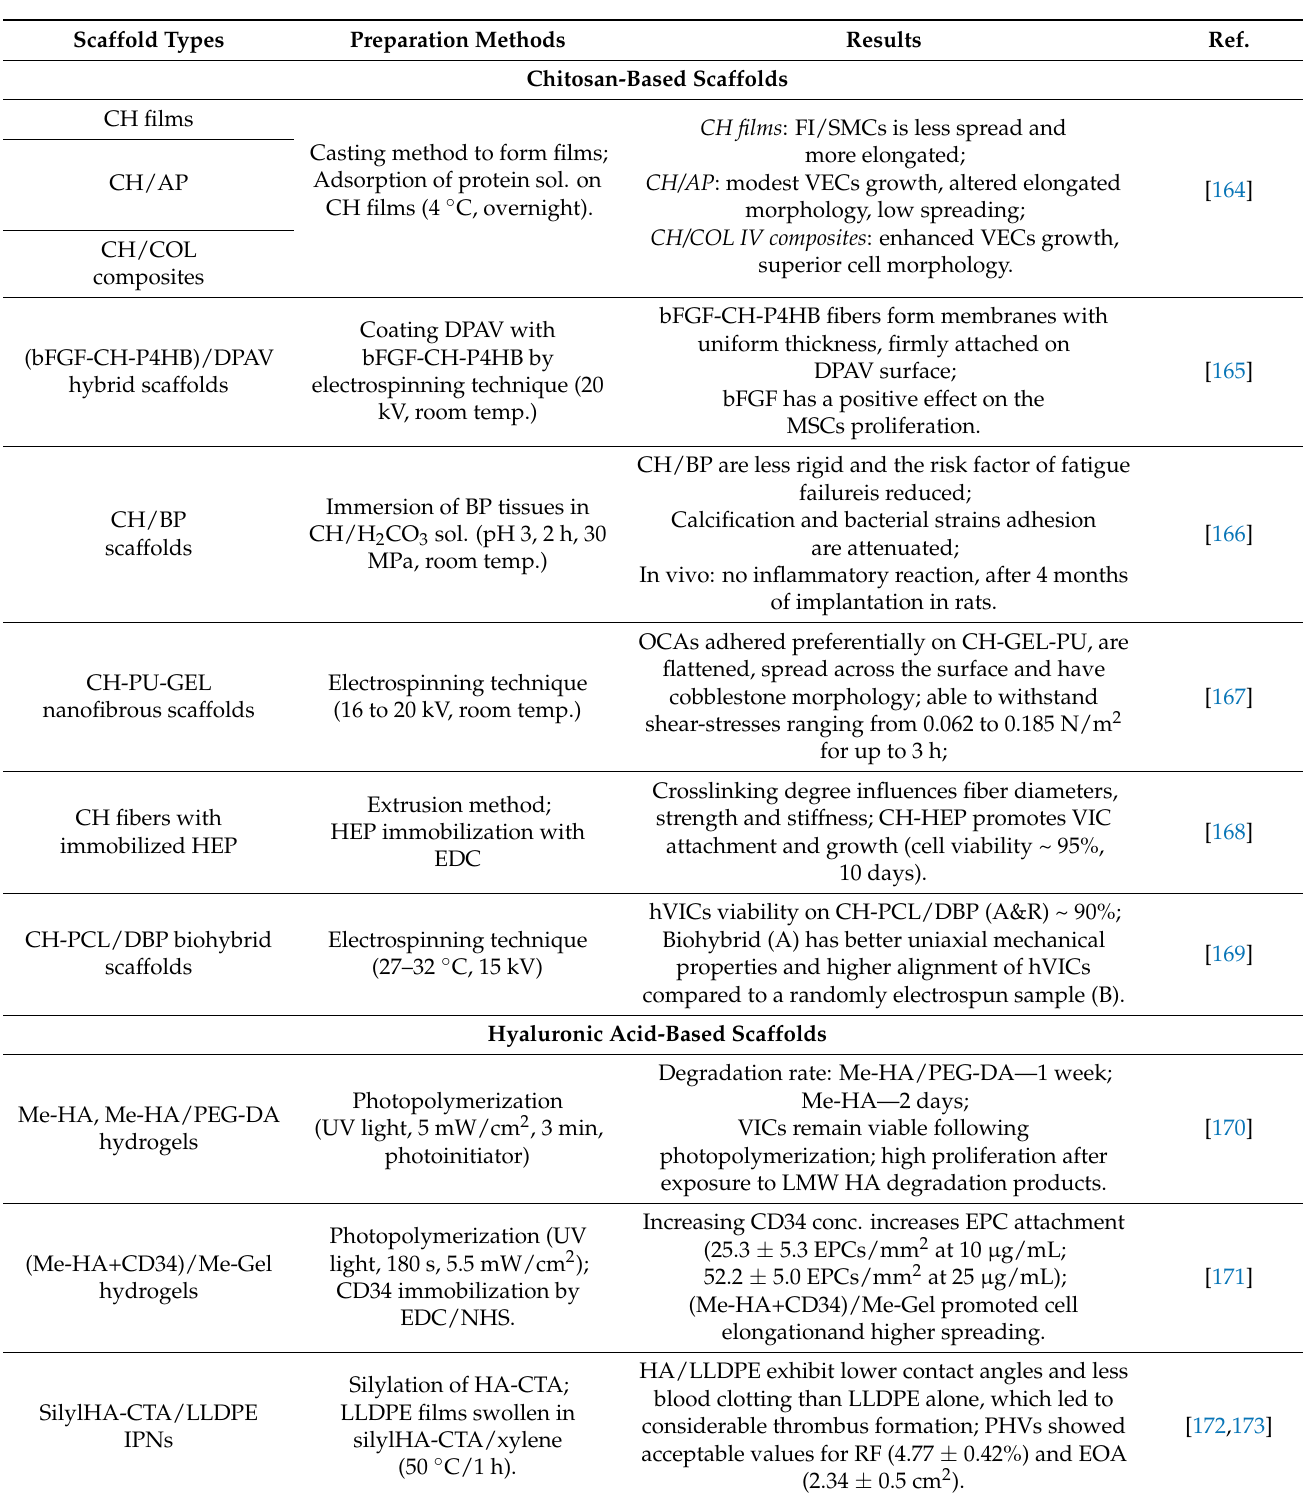
Table 5. Polysaccharide-based scaffolds for tissue-engineered heart